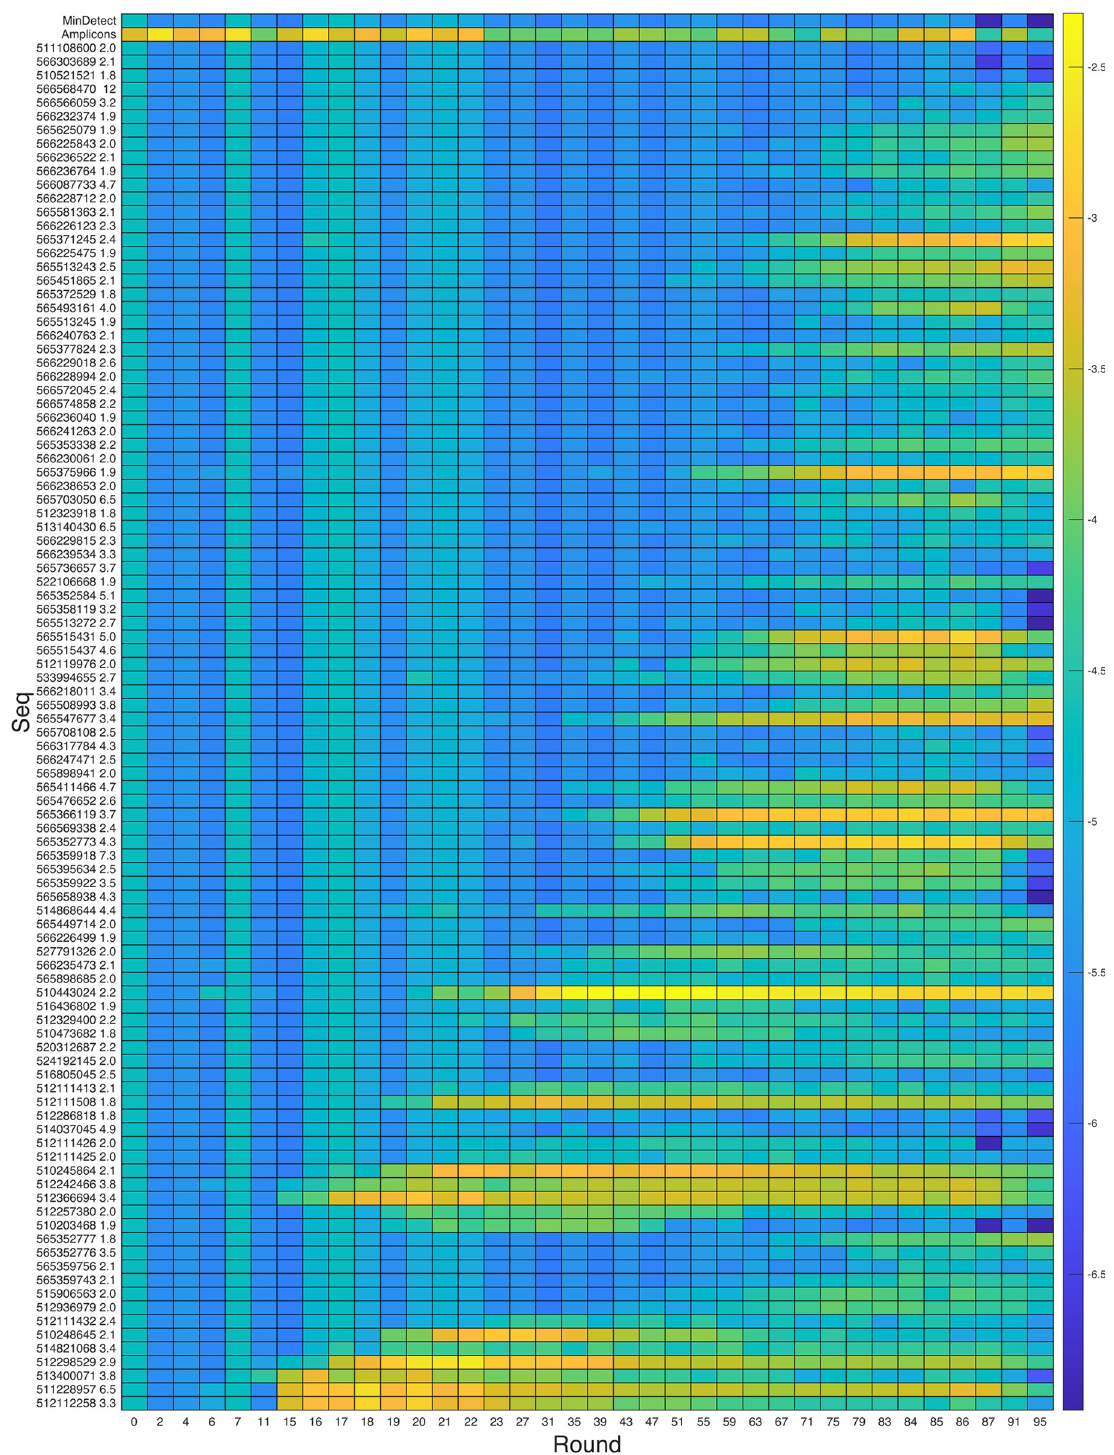
Fig 8. Tracking biosensors enrichment over selection rounds reveals amplicons make up large portion of pool early in selection before being outcompeted by true biosensors. Relative abundance is shown over the course of the selection as measured by sequencing of the products of the indicated rounds. The top row shows the minimum detectable abundance based on the total number of sequencing reads for each round, and the second row shows the abundance of short amplicons. The remaining rows show the 100 biosensors with the highest fold-change of those detected at round 87 or 95. Sequence ID and fold change of cleavage are shown along the y-axis labels and the pseudocolor represents log 10